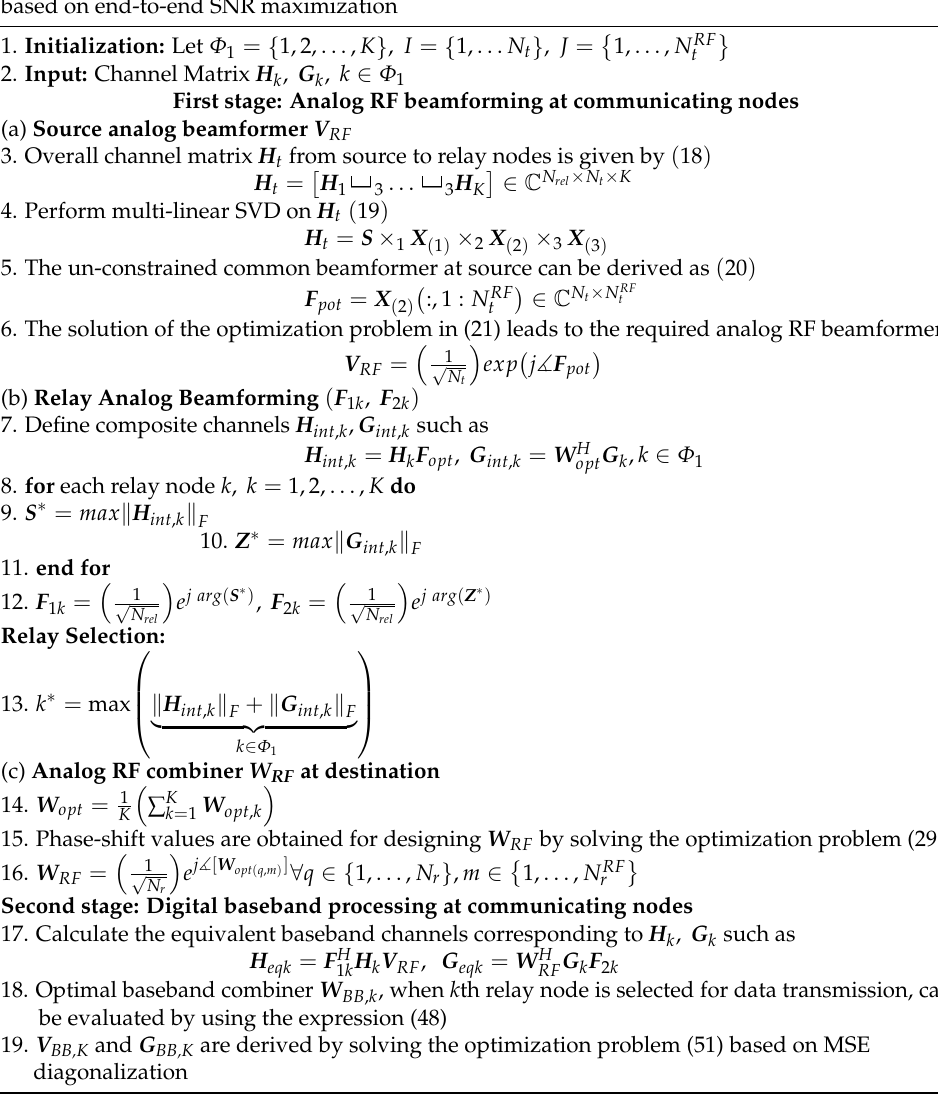
Table 1. Summary of the proposed algorithm. Algorithm: Hybrid transceiver and relay selection in a single-user multi-relay MIMO systems based on end-to-end SNR